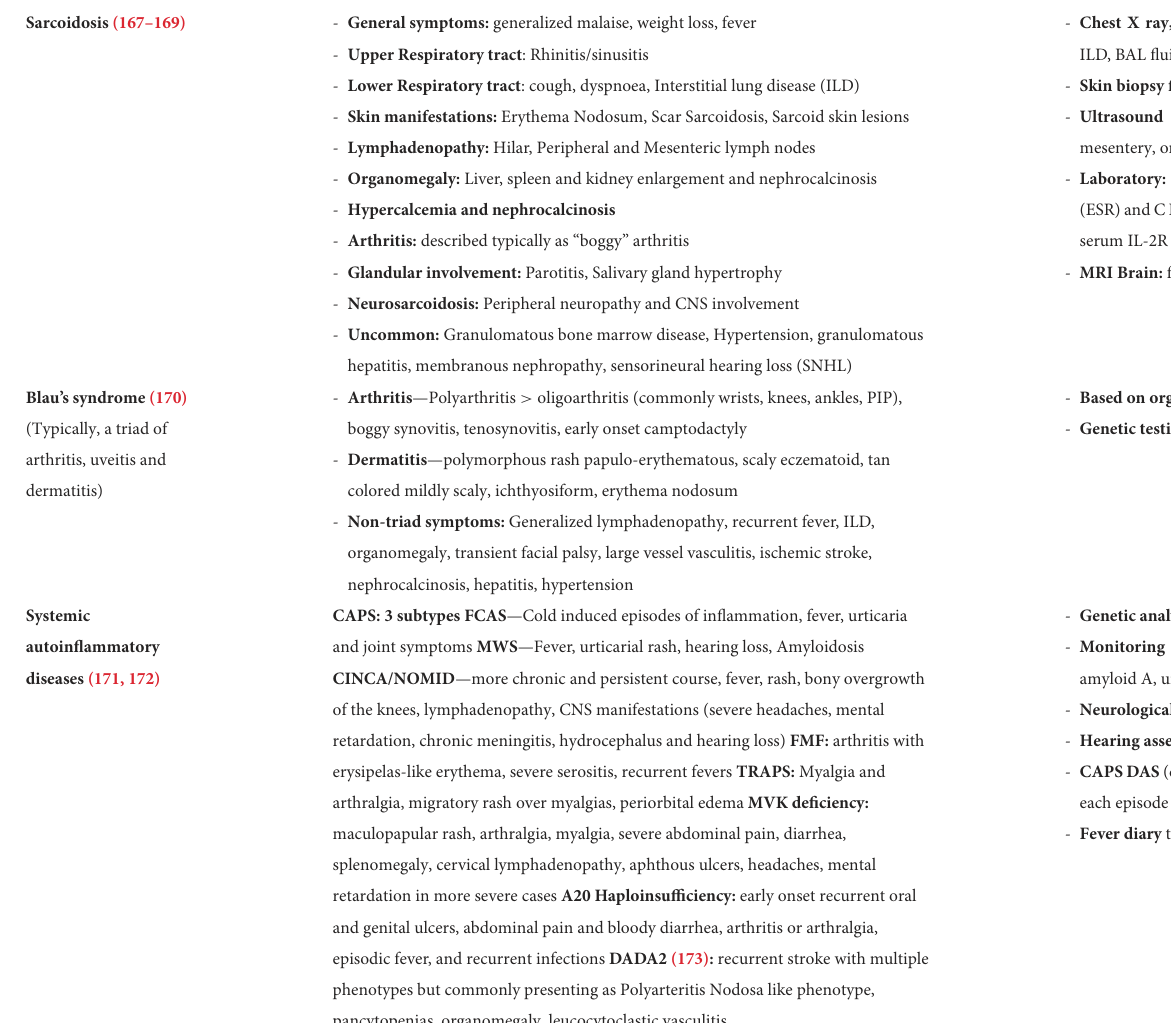
TABLE 5 Extra-ocular involvement and